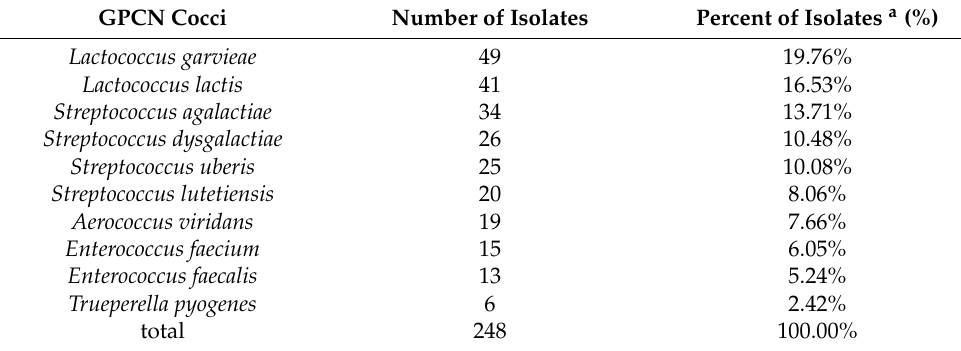
Table 2. Identification of suspected GPCN isolates by 16S rDNA sequence.